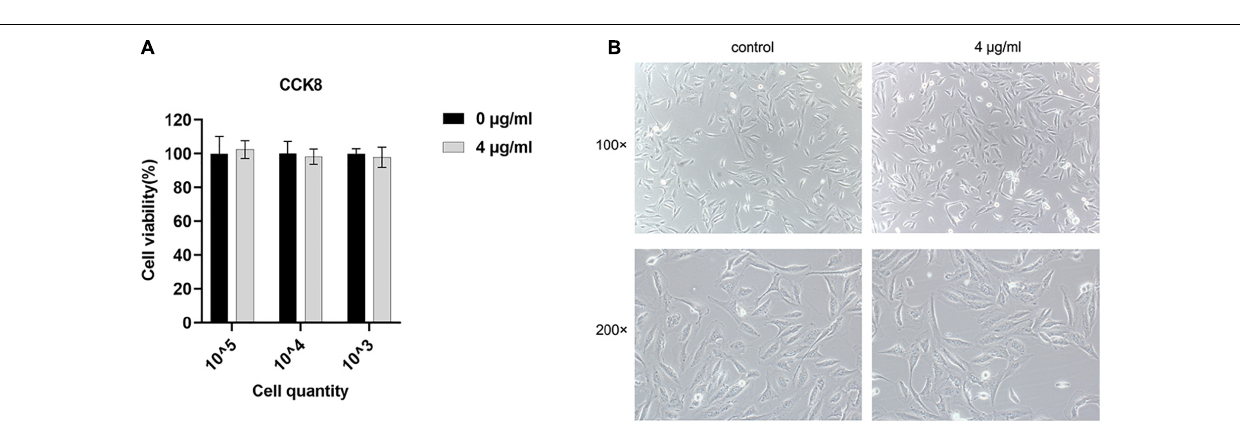
FIGURE 11 | The effect of SYG-180-2-2 on BEAS-2B. (A) The activity of different amounts of BEAS-2B with or without SYG-180-2-2 treatment. (B) Microscopic cell